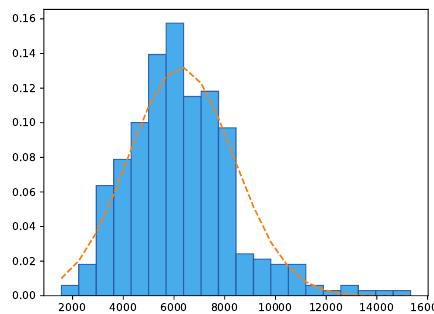
Figure 3. Class attribute y distribution-biomass in kg · ha − 1